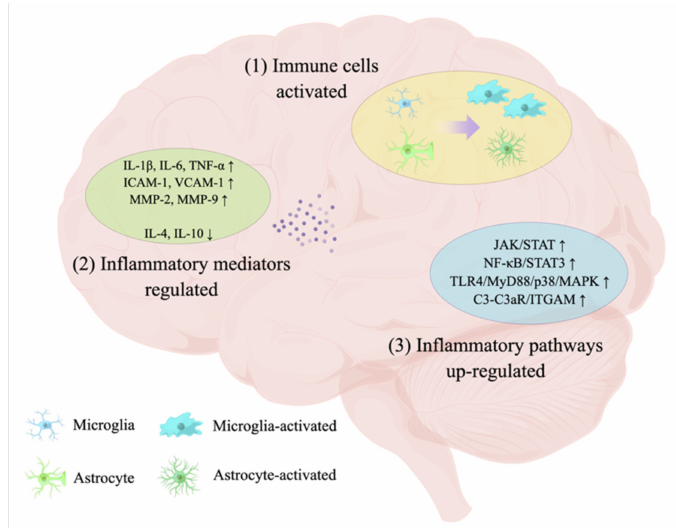
Figure 2. Neuroinflammation in